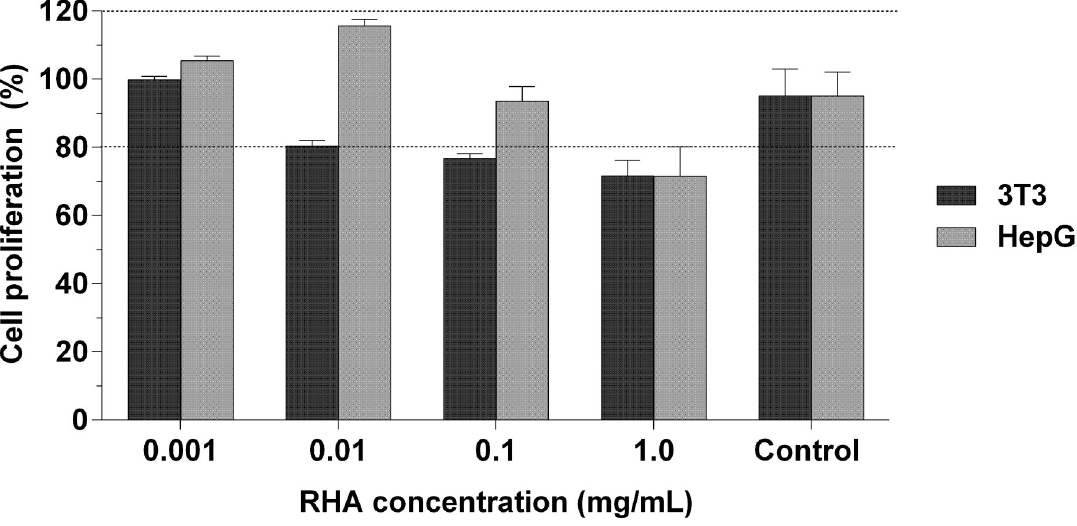
Fig 5. Cytotoxicity of RHA against 3T3 and HepG2 cells. Concentration of extract (RHA): 0.001 to 1.0 mg/mL. On the x-axis, there are the RHA concentrations (in mg/mL) and assay control, and on the y-axis, the percentage of cell proliferation. Results expressed as mean ± standard error of the mean (n =